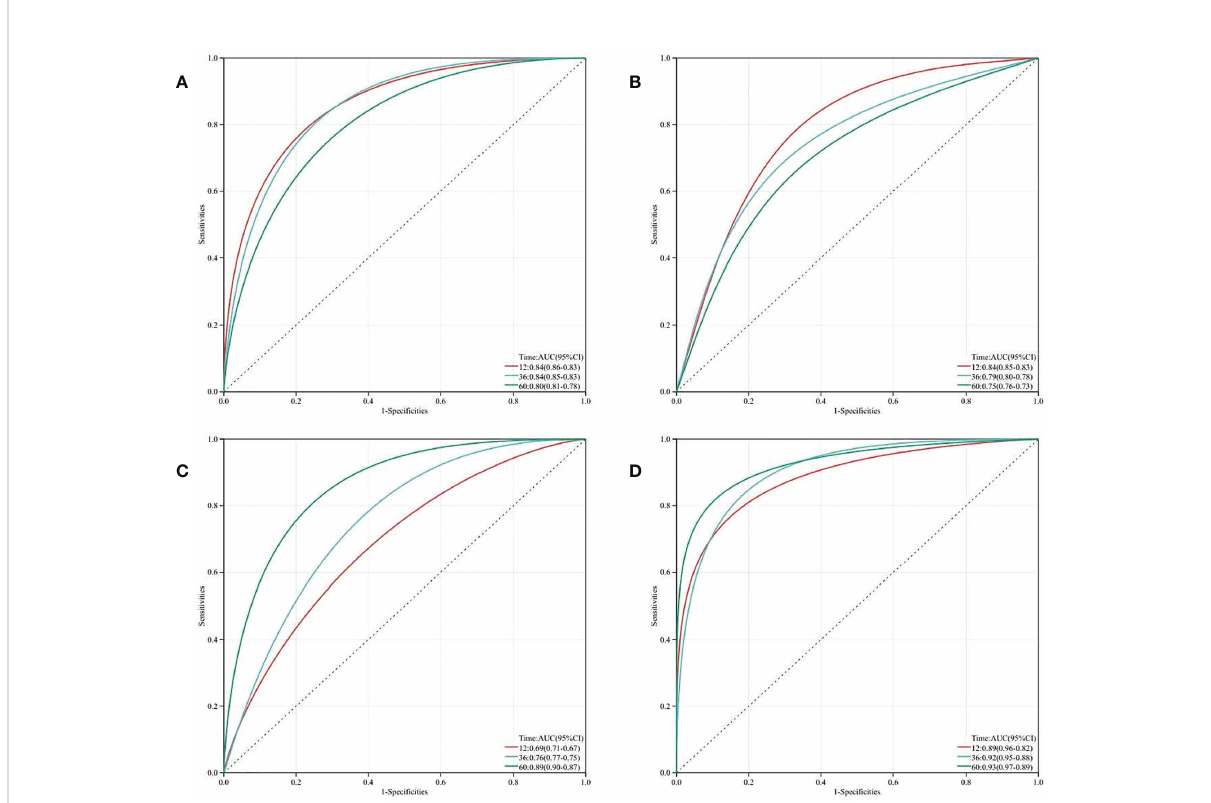
FIGURE 3 Time-dependent receiver operating characteristic curve (ROC) analysis with the area under the curve, sensitivity and speci fi city of LVEF (A) , NYHA class (B) , TyG Index (C) and LVEF + NYHA class + TyG Index (D) in predicting MACEs of T2DM patients after CABG surgery.